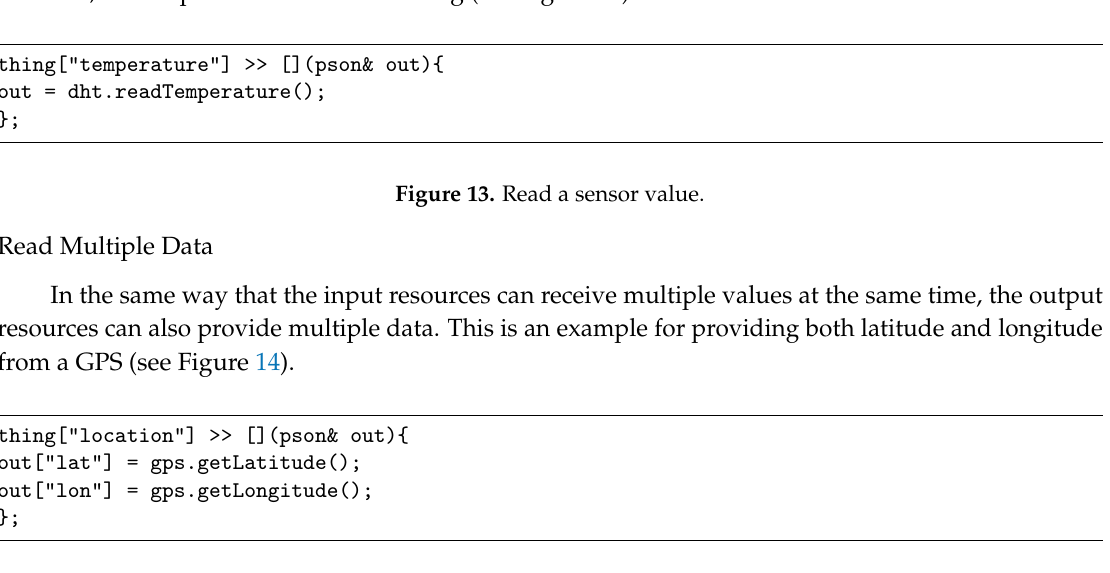
Figure 14. Read multiple data.